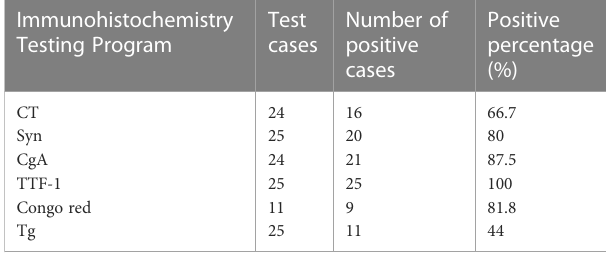
TABLE 2 Information on immunohistochemical testing of the patient ’ s MTC lesions. Immunohistochemistry